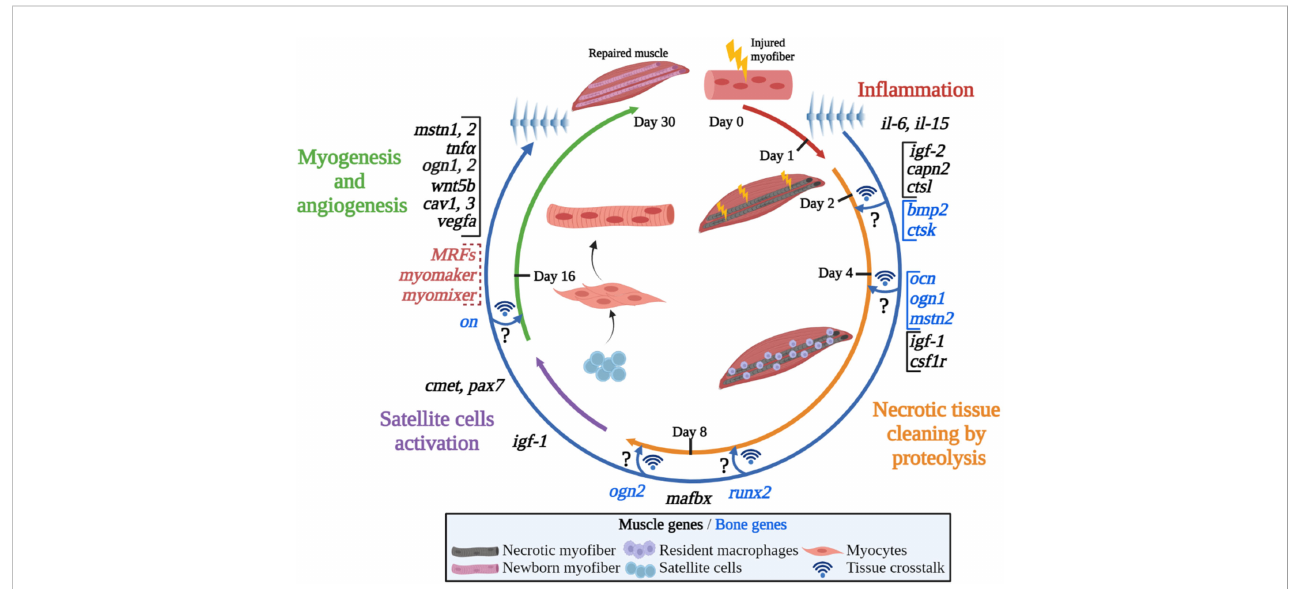
FIGURE 7 Graphical summary of the proposed model for fi sh muscle regeneration after an injury. The fi gure shows an overview of the different processes occurring after an injury in the gilthead sea bream muscle in a circular way, presenting the progressive appearance of the main molecules transcriptionally upregulated/modulated in both, muscle and bone. The circle is divided into the four main steps that take place during the regeneration process, from the initial in fl ammation and proteolysis to the satellite cells activation and myogenesis. Note that Mrfs, myomaker and myomixer data has been extracted from (65). The hypothetical muscle and bone interactions suggested are indicated by crossing arrows and question mark symbols. Created with